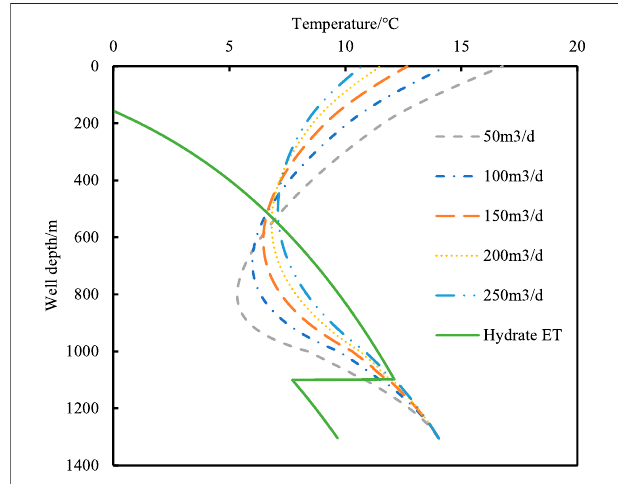
FIGURE 3 | Hydrate formation region in the drainage line under varied water production rates.